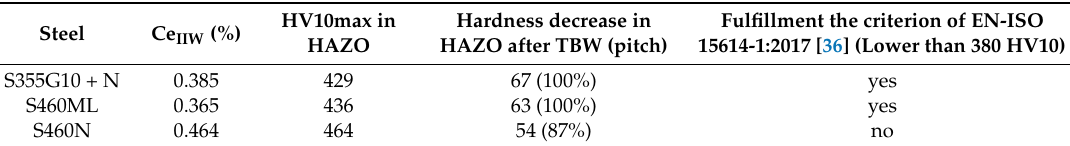
Table 6. Comparison of hardness HV10 for different steels for the TBW technique